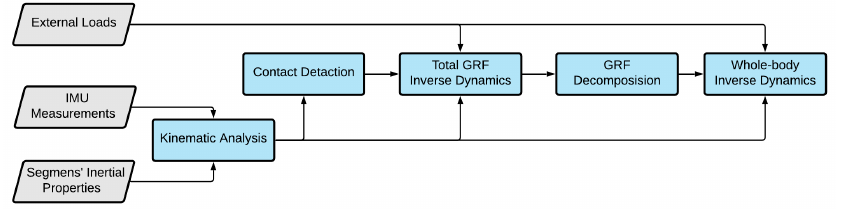
Figure 1. Flowchart of the whole-body inverse dynamics model.